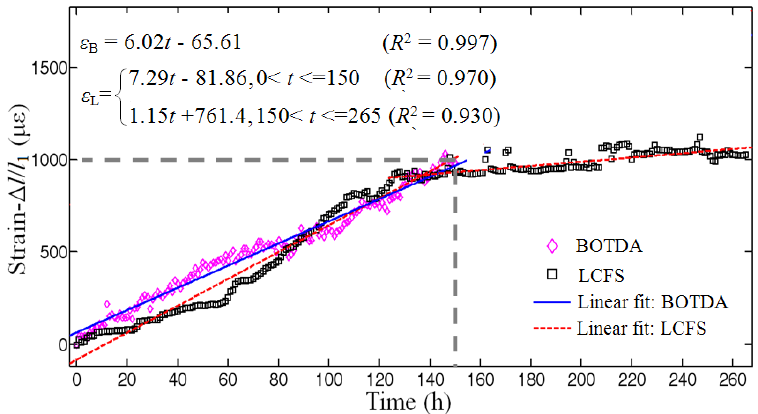
Figure 7. Comparison on the total strain over the sensing fiber of the specimen between the integrated results from the data obtain by the BOTDA and these measured by the LCFS in the electrochemical corrosion acceleration